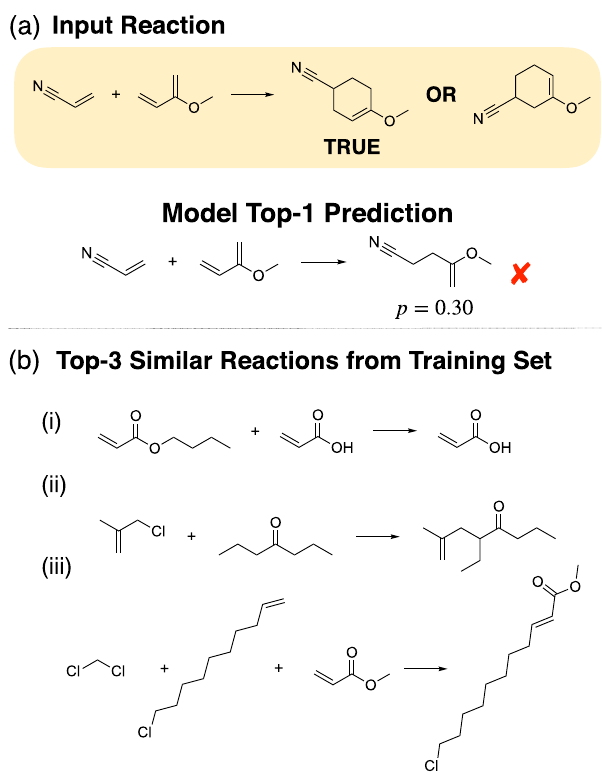
reactions or that no Diels – Alder reaction is present in the